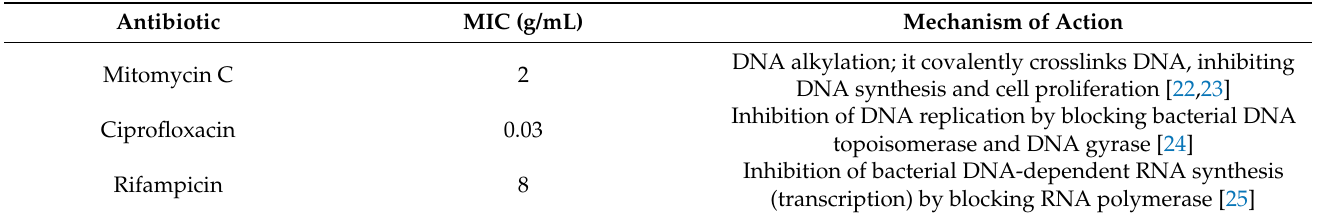
Table 1. MIC values (against the E. coli O157:H7 (ST2-8624) strain) and mechanisms of action of used antibiotics. Antibiotic MIC (g/mL) Mechanism of Action DNA alkylation; it covalently crosslinks DNA, inhibiting Mitomycin C 2 DNA synthesis and cell proliferation [22,23] Inhibition of DNA replication by blocking bacterial DNA Ciprofloxacin 0.03 topoisomerase and DNA gyrase [24] Inhibition of bacterial DNA-dependent RNA synthesis Rifampicin 8 (transcription) by blocking RNA polymerase